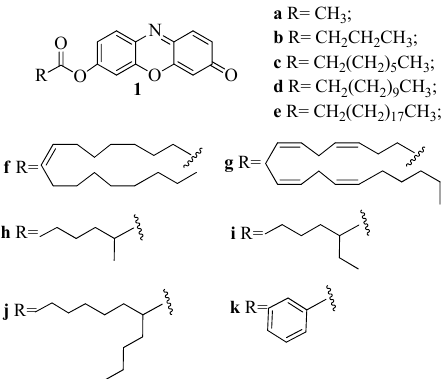
Figure 1. Structures of 7-hydroxyresorufynil esters: acetate ( 1a ), butyrate ( 1b ), octanoate ( 1c ), dodecanoate ( 1d ), icosanoate ( 1e ), oleate ( 1f ), arachidonate ( 1g ), 2-methylhexanoate ( 1h ), 2-ethylhexanoate ( 1i ) 2-butyloctanoate ( 1j ), benzoate ( 1k ).